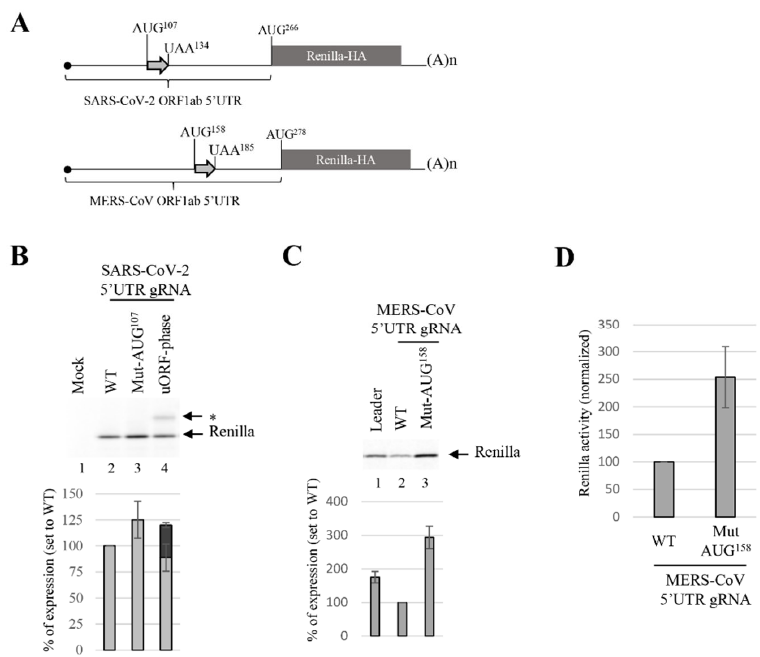
Figure 7. The 5 ′ UTR uORF differentially regulates translation from SARS ‐ CoV ‐ 2 and MERS ‐ CoV. ( A ) Scheme of the reporter mRNA with the 5 ′ UTR ORF1ab of SARS ‐ CoV ‐ 2 or MERS ‐ CoV gRNA with their respective uORF and positions. ( B ) Capped and polyadenylated mRNA harboring the SARS ‐ CoV ‐ 2 5 ′ UTR gRNA WT or the Mut ‐ AUG 107 or uORF ‐ phase mutations were translated in the RRL. Translation products were resolved by 12% SDS ‐ PAGE and quantified with a phosphoImager. ( C ) Capped and polyadenylated mRNA harboring the MERS ‐ CoV 5 ′ UTR gRNA WT or the Mut ‐ AUG 158 mutation, were translated in the RRL. Translation products were resolved by 12% SDS ‐ PAGE and quantified with a phosphoImager. ( D ) Jurkat cells were electroporated with capped and polyad ‐ enylated mRNAs as indicated. After 90 min of incubation, the cellular extracts were used for lucif ‐ erase assay and RT ‐ qPCR. Values shown are the mean (+/ − S.D.) for three independent experiments.